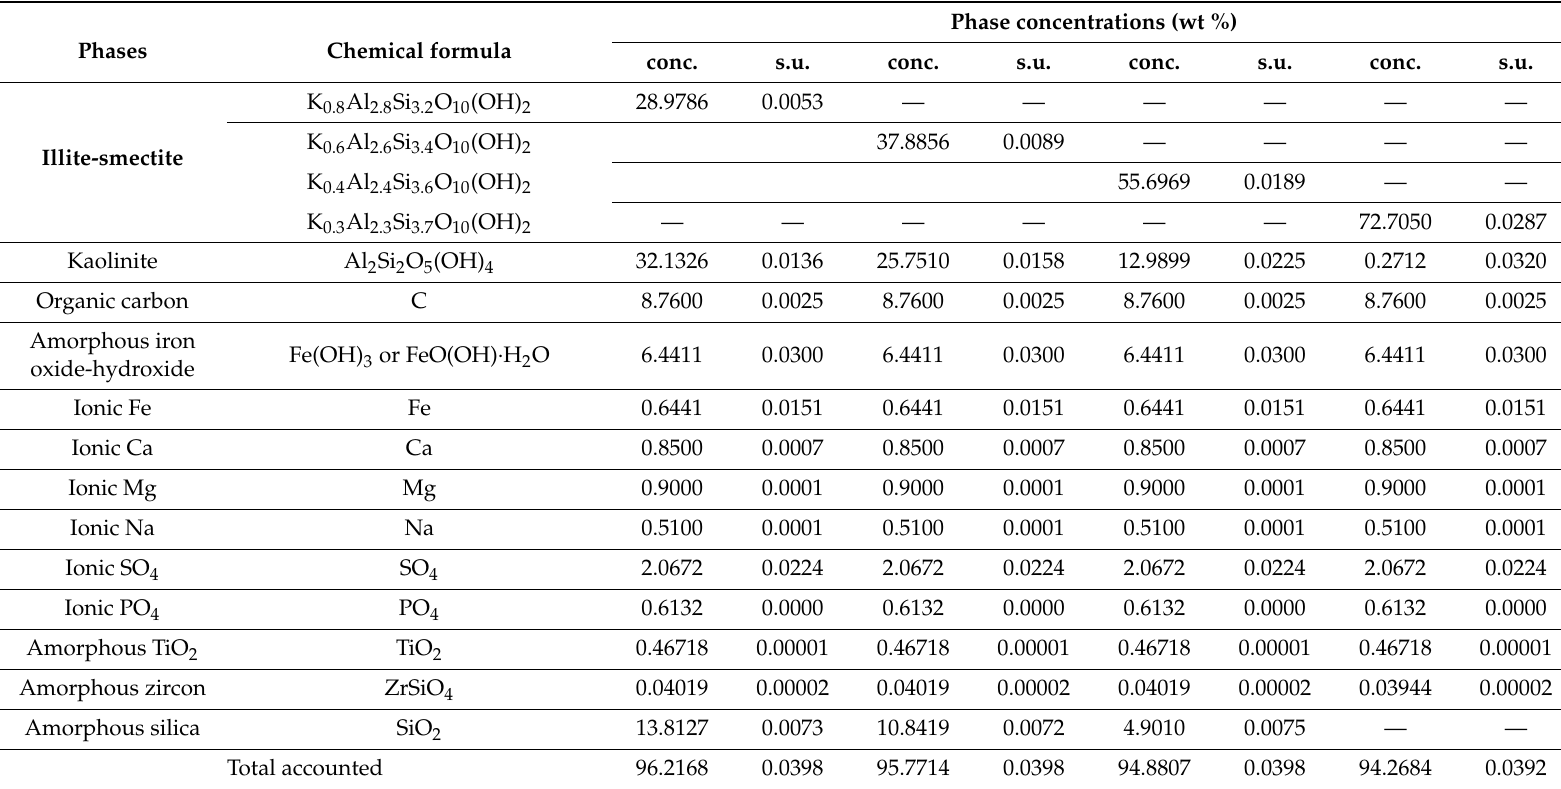
Table 3. Elemental and mineralogical compositions determined for ultrafines ( < 0.2 µ m solids) separated from typical commercial oil sands bitumen froth (acronyms used and data reported as per Table 2). The term “amorphous” refers to poorly-crystalline or finely-dispersed phases not discernable in XRD powder patterns. Again, as illite-smectite interstratification is known to occur in oil sands [33], we then identify the corresponding phase as “illite-smectite”; however, not knowing its chemical formulae, we assumed here pure illitic nominal stoichiometries for performing quantitative phase